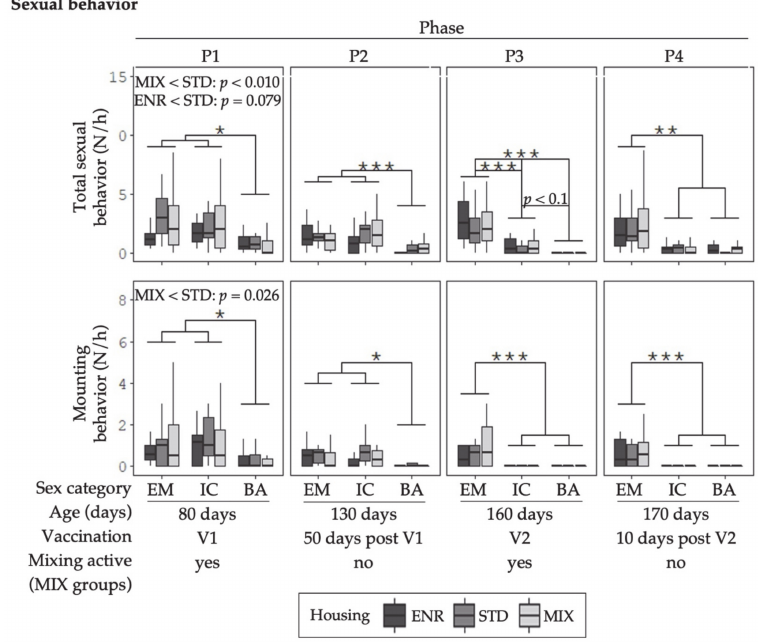
Figure 3. Mean number of occurrences (N) of sexual behaviors per hour (h) for each animal are given as boxplots for the sex categories in the different environments. Columns represent the data of animals in four different behavior observation phases (P1–P4). V1 represents phases before, and V2 after the second immunization of IC. The MIX pens were mixed in P1 and P3. Note: no mixing was done in STD and ENR at any time. Sex categories were: EM = entire males, IC = immunocastrates, BA = barrows; Housing environments were: ENR = enriched, STD = standard, MIX = mixing. Significant differences between sex categories are indicated by asterisks (*** p < 0.001, ** p < 0.01, * p < 0.05). Housing differences are annotated with p -values in the graphs respectively. Boxplots show the minimum value with respect to the interquartile range, the 25th percentile, the median, the 75th percentile and the maximum value with respect to the interquartile range.